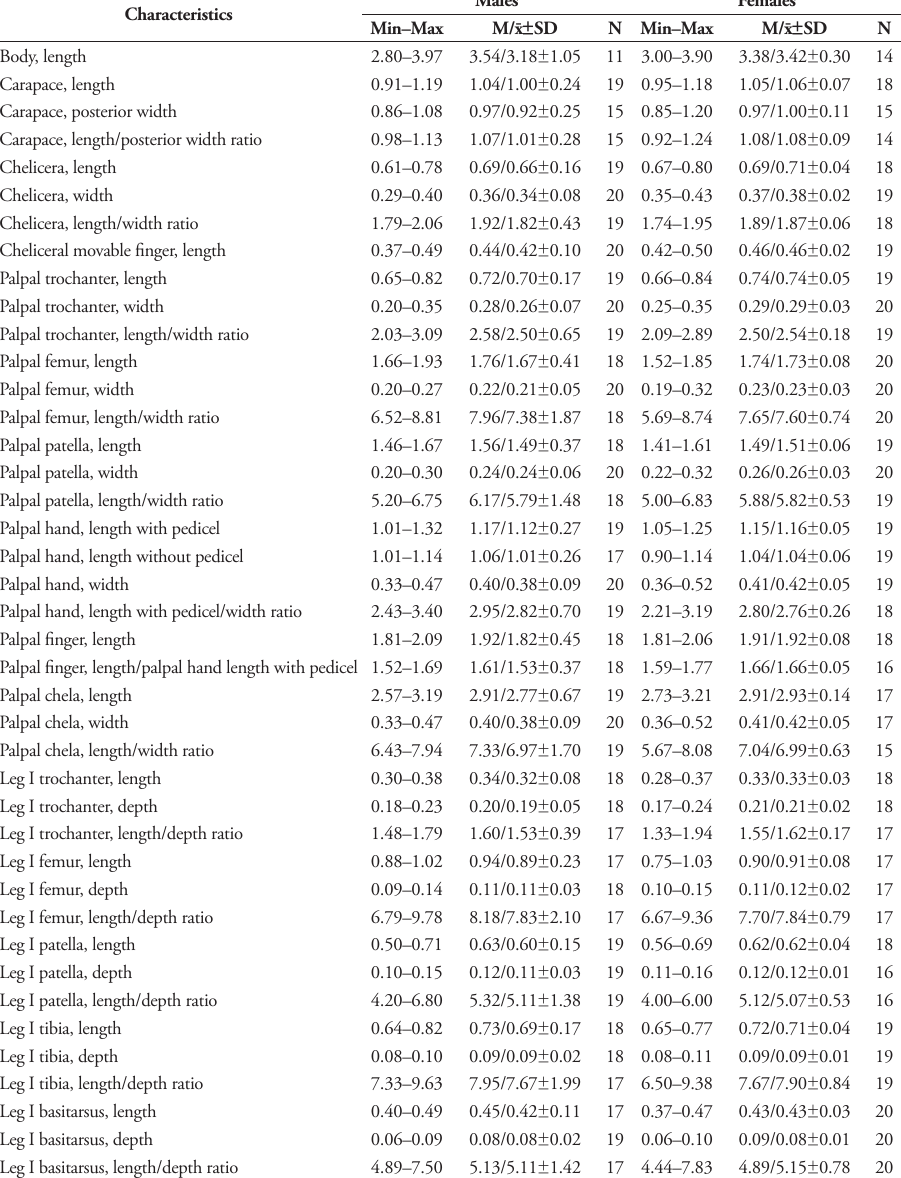
Table 2. Morphometric data for males and females of Neobisium slovacum (measurements in mm). Ab- breviations: M, median; Min, minimum; Max, maximum; N, number of individuals measured; SD, standard deviation; x¯, arithmetic